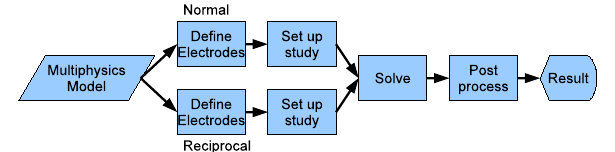
Fig. 21: Overview of experiment processes. The process is based on the model previously defined. This is done using Multiphysics.